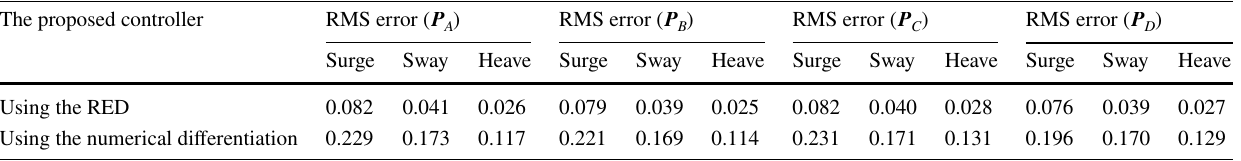
Table 2 RMS errors (m) at the steady state for the proposed controller using RED against numerical differentiation method under measurement t ) d ( t ) = 0.723sin ( t ) s noise 𝜻 ( and measurement delay The proposed